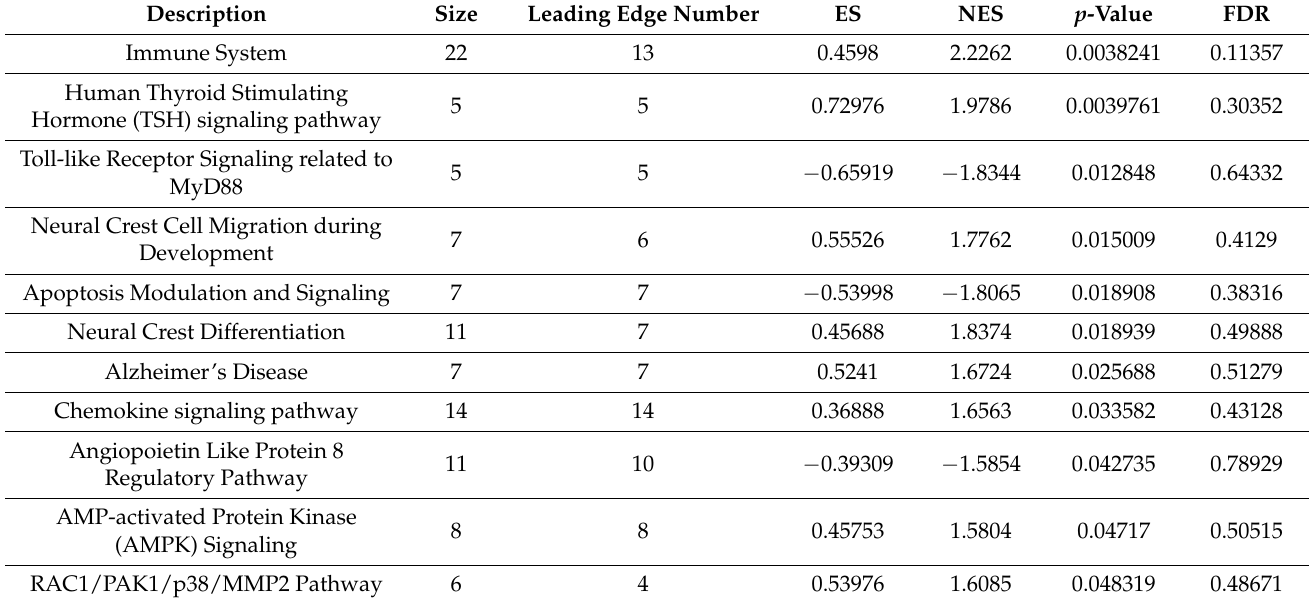
Table 2. The top ten functional pathways significantly regulated in macrophages by colostrum exosome encapsu- lated